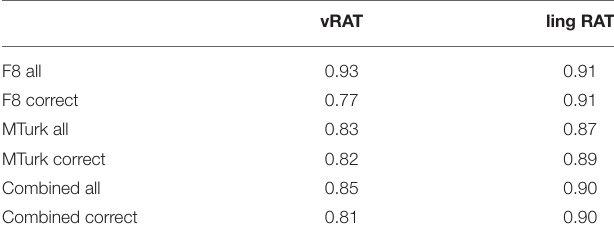
TABLE 7 | Cronbach’s alphas of the response time metrics of